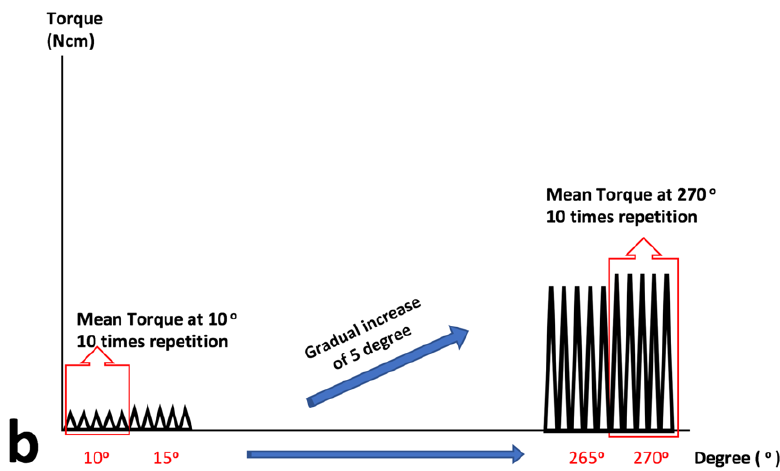
Figure 1. Custom-designed device used in this study. ( a ) File holding part (dotted box, magnified view) and ( b ) method to make repetitive torsional load conditions by automatic repetition of rotational load using gradual increase of rotational degree.